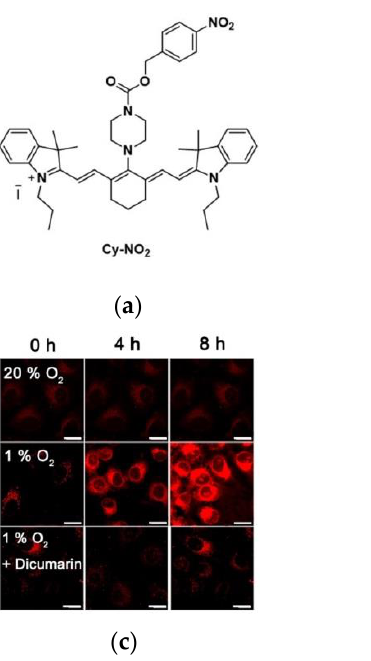
Figure 9. ( a ) Structure of probe Cy-NO 2 ; ( b ) Fluorescence spectra of Cy-NO 2 ; ( c )Fluorescence images of A549 cells; ( d ) Fluorescence imaging of Cy-NO 2 in normal and tumor-bearing mice. Reproduced with permission from [61]. Copyright 2018 Elsevier B.V.